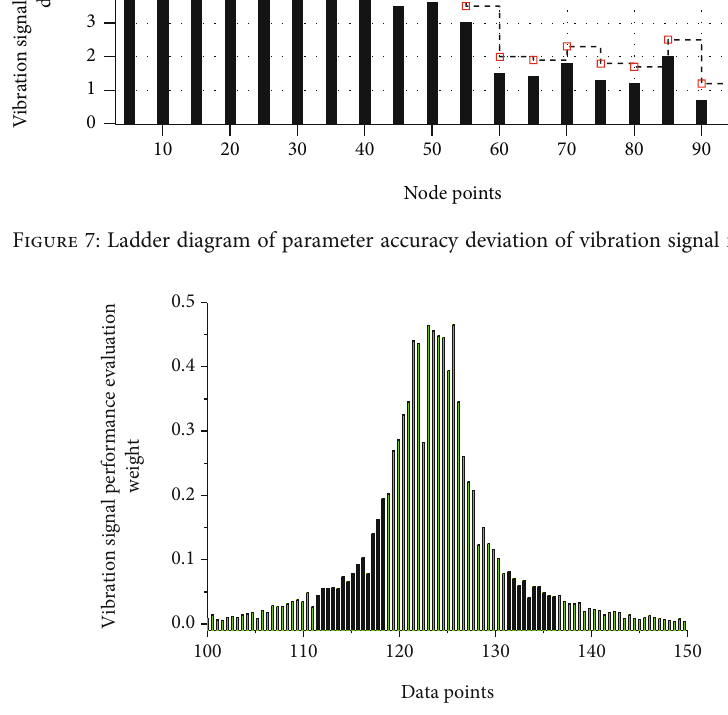
Figure 8: Histogram of vibration signal performance evaluation